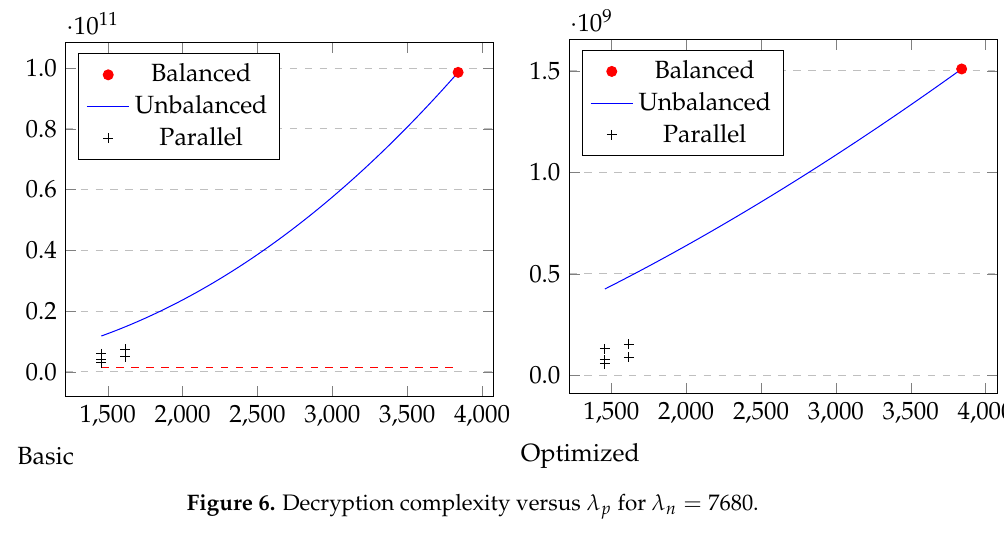
Figure 6. Decryption complexity versus λ p for λ n = 7680.